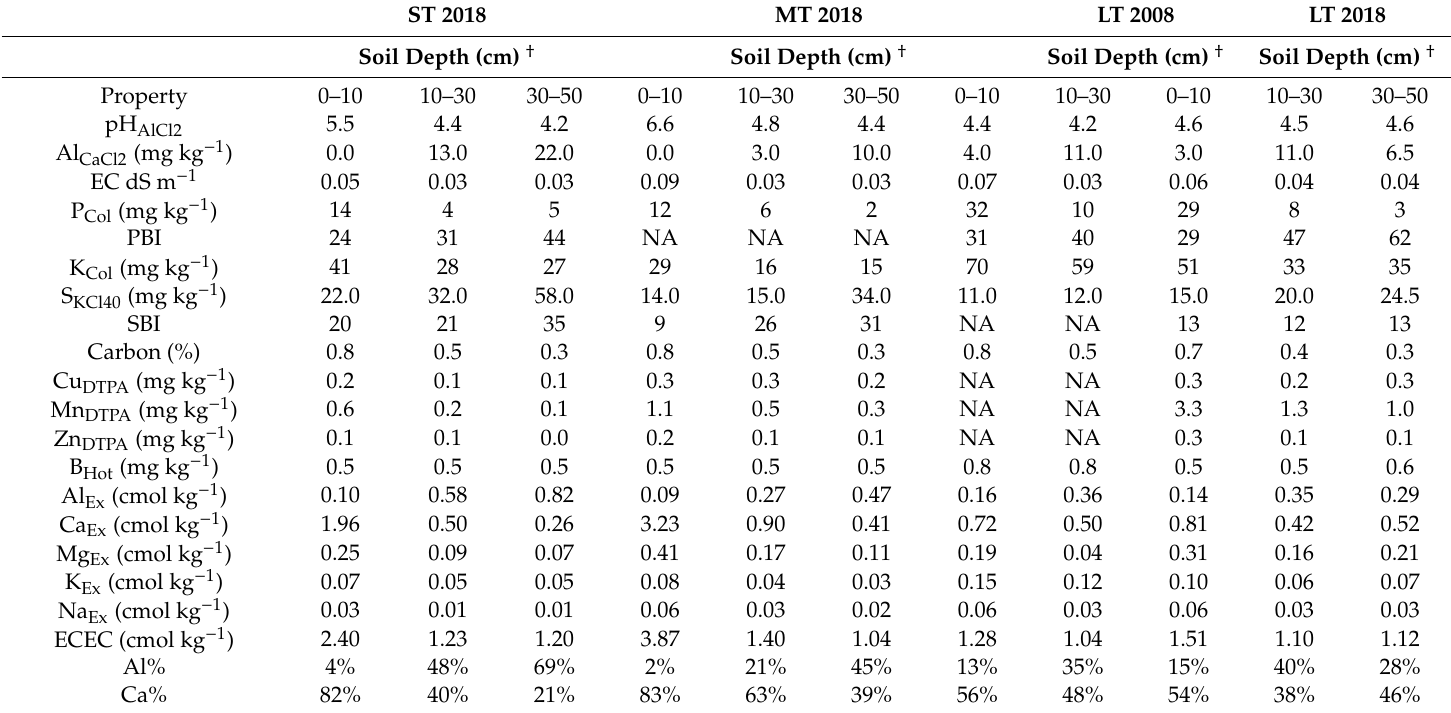
Table 1. Selected soil properties at the beginning of the long term (LT) field study in March 2008 at two soil depth increments (0–10 and 10–30 cm), and in March 2018 at three depth increments (0–10 and 10–30 and 30–50 cm), for the short term (ST), medium term (MT) and LT experiments in March